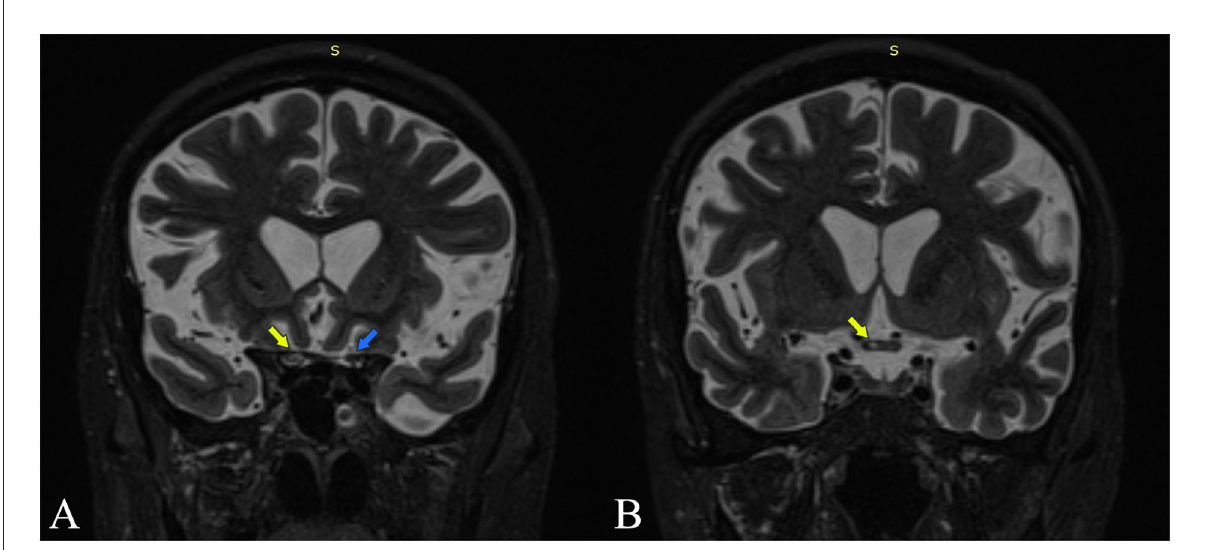
FIGURE2 Coronal MRI STIR sections are at the intracranial optic nerves (A) and optic chiasm (B) . Yellow arrows point out increased STIR signal intensity at the level of the right optic nerve and the right side of the chiasm. The blue arrow points out the left optic nerve with normal signal